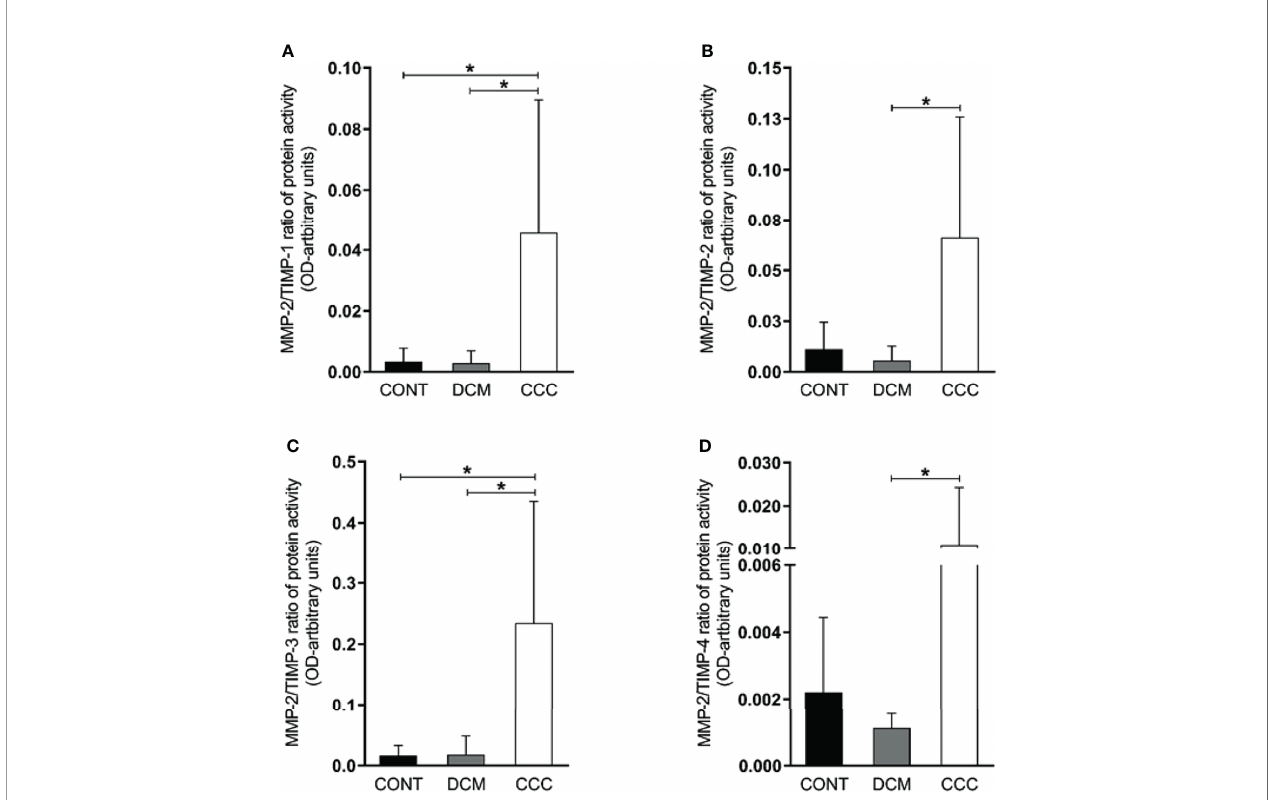
FIGURE 5 | Ratios of MMP2/TIMP in heart tissue from CCC and DCM samples. Activity of MMP-2/expression protein TIMP stoichiometric ratios were calculated for samples CCC, DCM and control. (A) MMP-2/TIMP-1. (B) MMP-2/TIMP-2. (C) MMP-2/TIMP-3. (D) MMP-2/TIMP-4. *P -values were considered signi fi cant if p-value (0.05) corrected for multiple comparisons by Bonferroni ’ s method (corrected p-value = 0.05/3 =